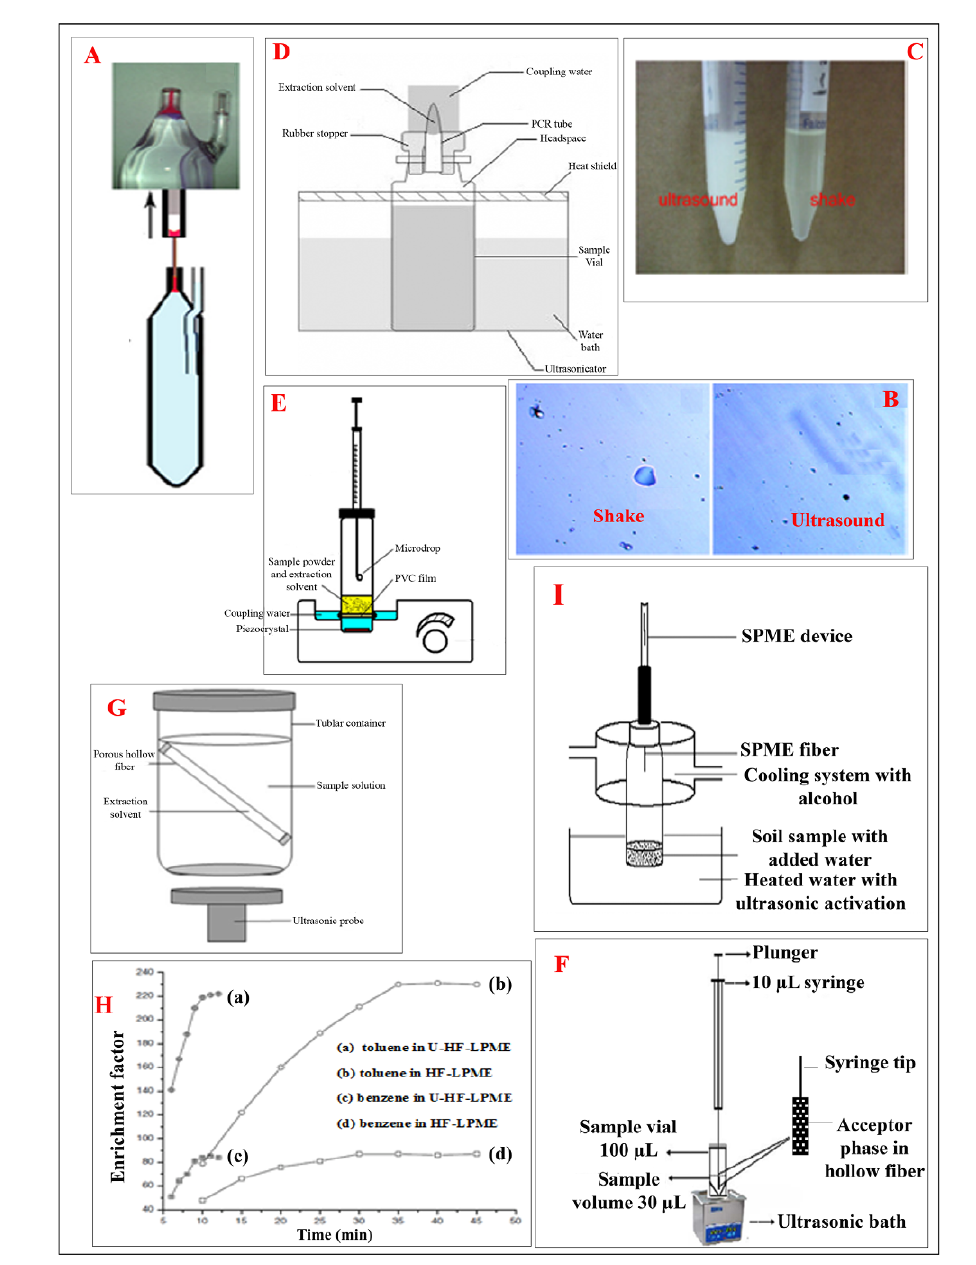
Figure 9. Different types of ultrasound assisted microextraction methods; (A) USAEME, (B) microphotographs of tetrachloroethylene droplets attained by vigorously stirring and sonication after 5 min, (C) comparison of ultrasound assisted DLLME and shake assisted DLLME, (D) schematic diagram of UA-HS-LPME apparatus, (E) UNE–HS-SDME system, (F) schematic diagram for the operation of UA-HF- LPME, (G) schematic illustration of the set-up for ultrasound assisted SBME, (H) comparison of extraction time of ultrasound assisted SBME and HF-LPME and (I) schematic diagram of extraction apparatus for SPME (reproduced with permission of Elsevier and Springer, Springer, -modified [